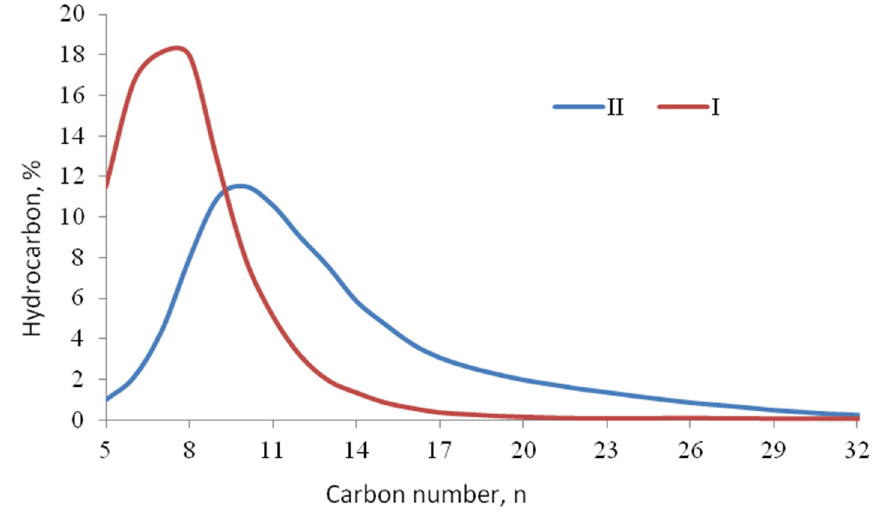
Figure 3. Hydrocarbon distribution on I and II catalysts at optimal FTS temperature.